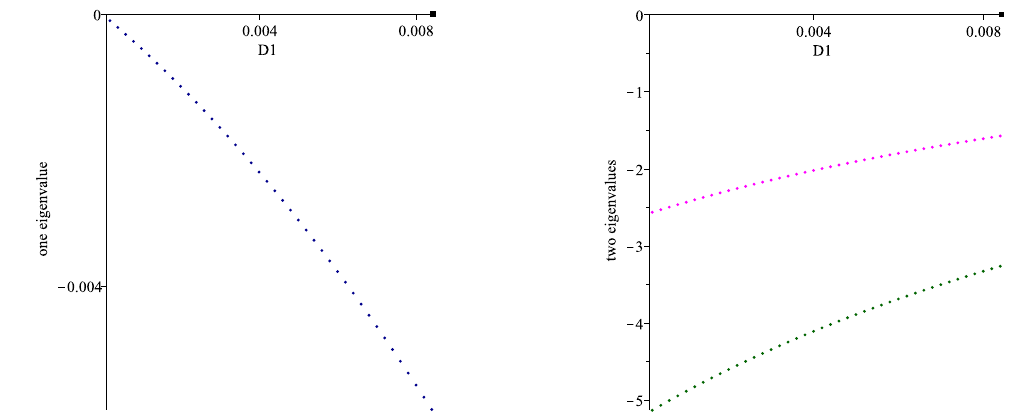
( 1 ) ) . The solid box on the 1